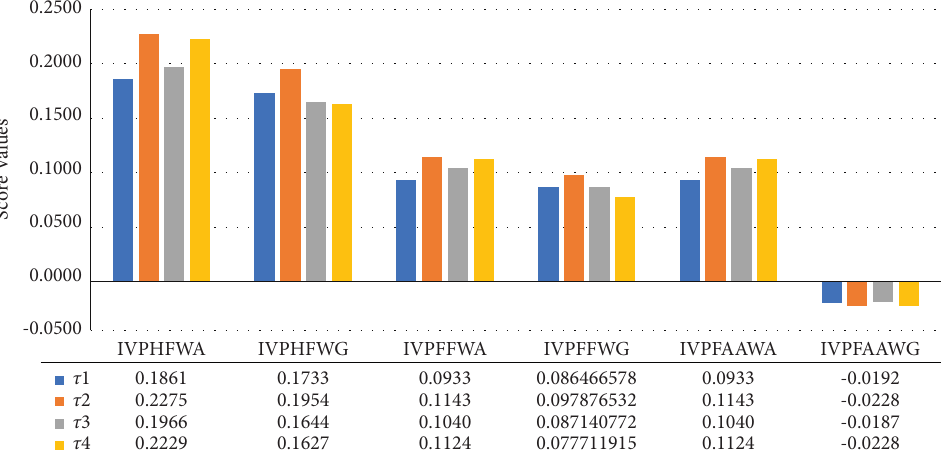
Figure 4: Comparison of existing AOs with proposed